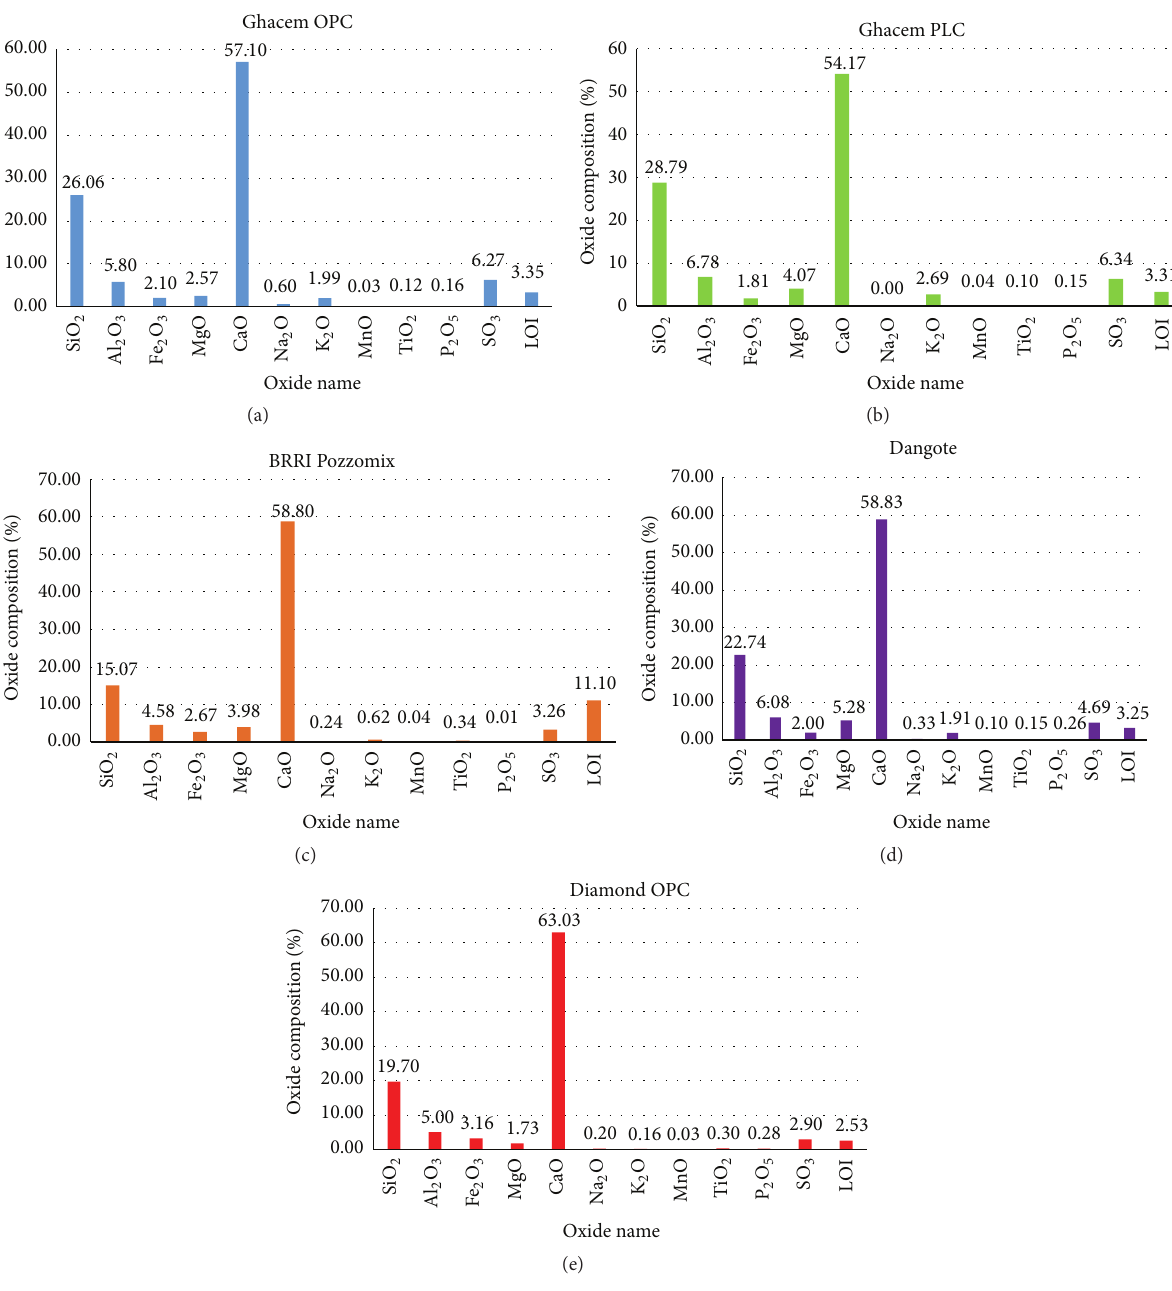
Figure 1: Oxides composition of commercial Portland cement in Ghana.